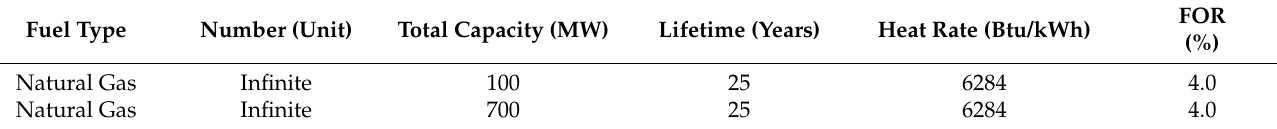
Table A8. List of candidate generation units.